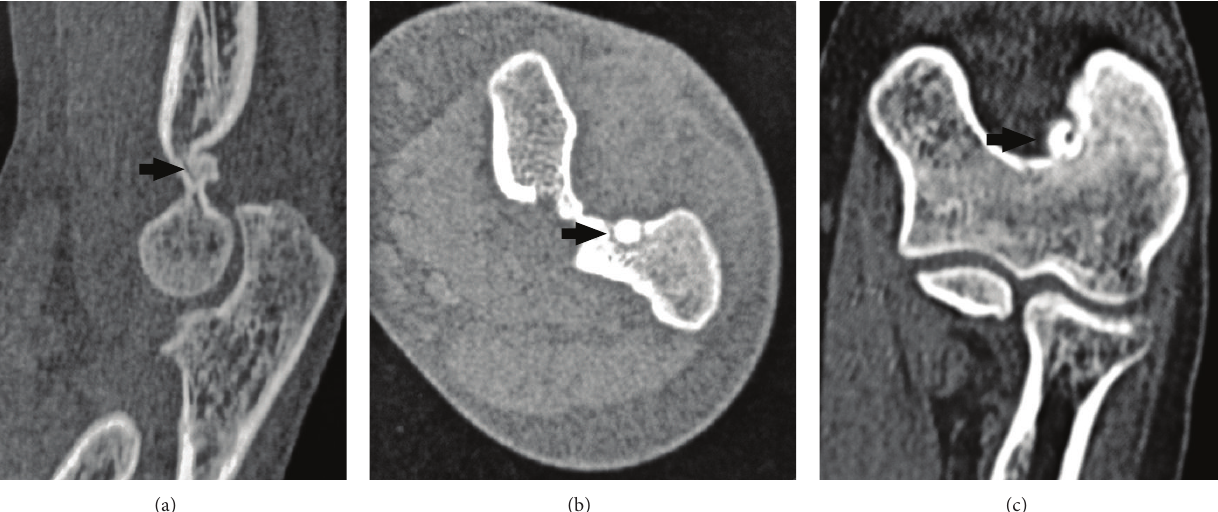
Figure 2: Sagittal, axial, and coronal computed tomography sections of the elbow show a 7mm diameter cystic lesion that respects the cortical bone and is located at the cartilage-cortical bone junction in the posterolateral part of the olecranon